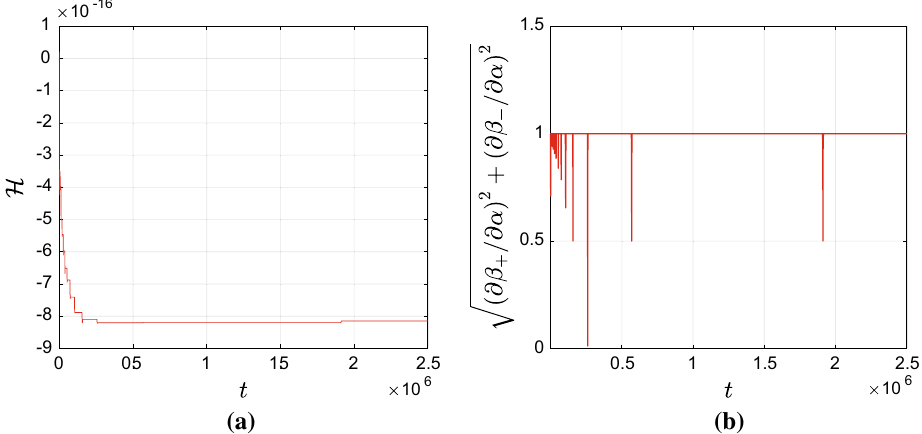
the Hamiltonian constraint becomes relevant and cannot be neglected in the approach towards the singularity (see [7] for a more detailed dis- cussion). Both plots correspond to the numerical solution shown in Fig.